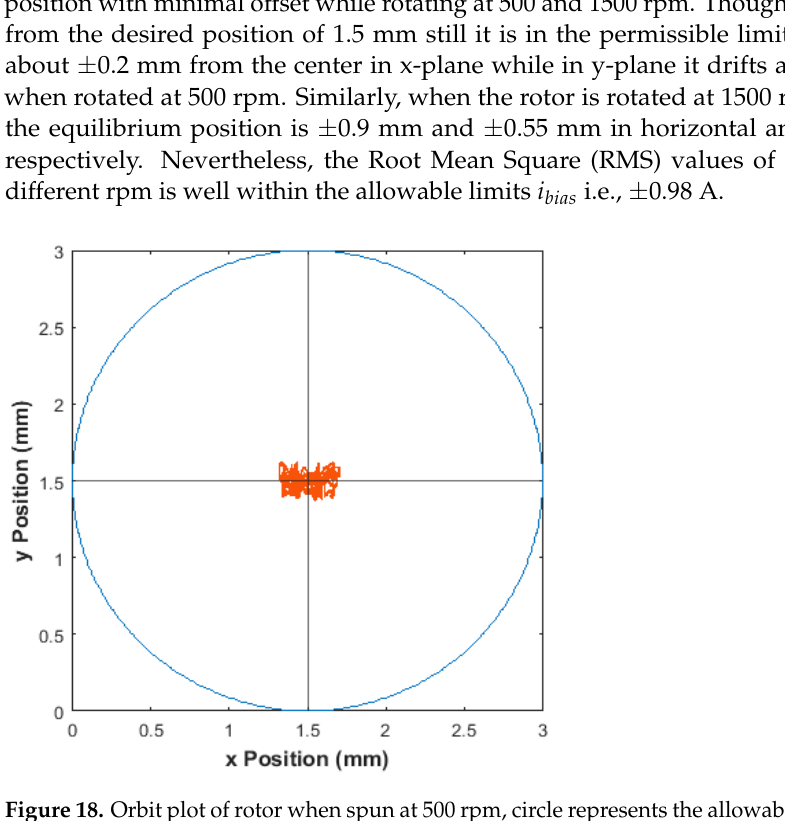
Figure 17. The response of AMB at 1500 rpm in both x and y planes.